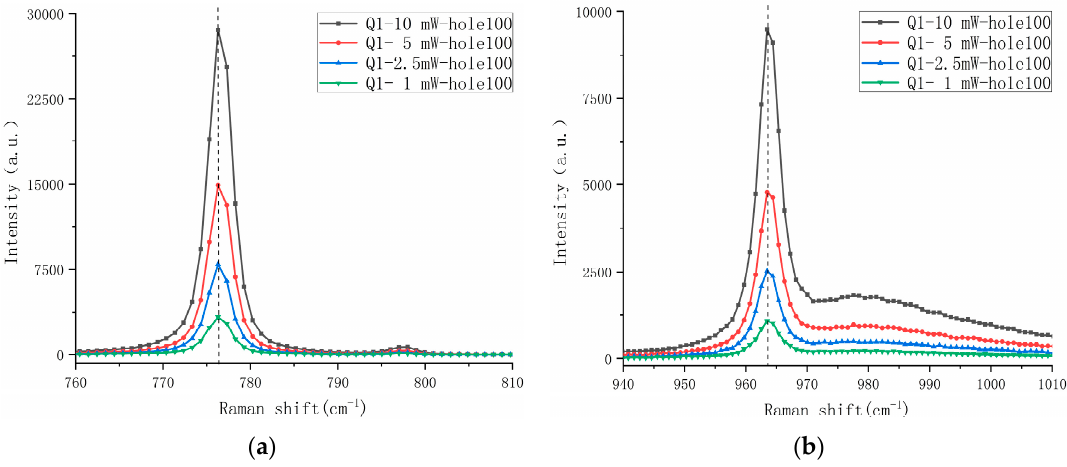
Figure 4. Raman spectra of the Q1 sample measured with exciting line at 532 nm with the 100 μ m pinhole, ( a ) TO mode, ( b ) LO and Longitudinal Optical Plasmon Coupled (LOPC) modes, using different laser powers as indicated in the legend, whilst focusing on the sample surface.